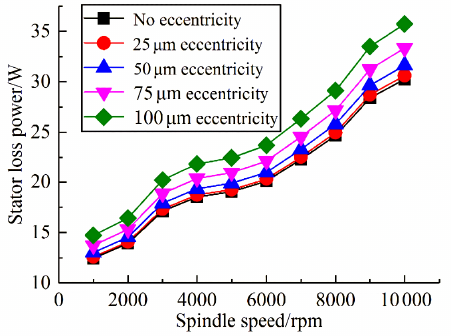
Figure 6. Maximum magnetic field strength with different rotating speed and